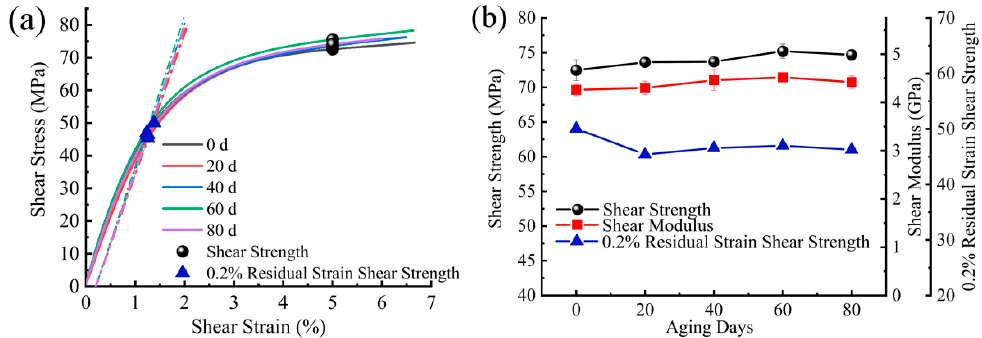
Figure 18. ( a ) V-notched shear stress–strain curve (in-plane); ( b ) in-plane shear properties during exposure to UV radiation.